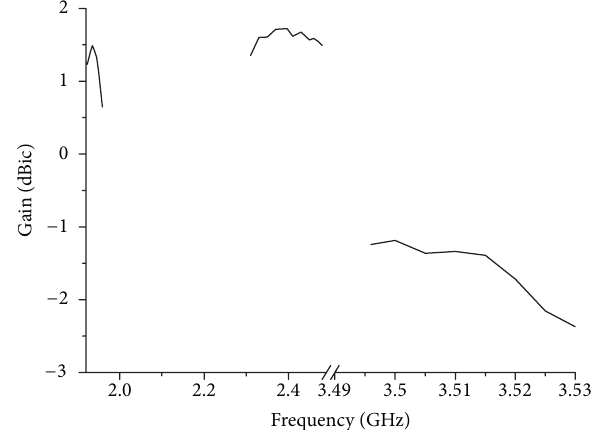
Figure 8: Measured CP gains against frequency for the proposed